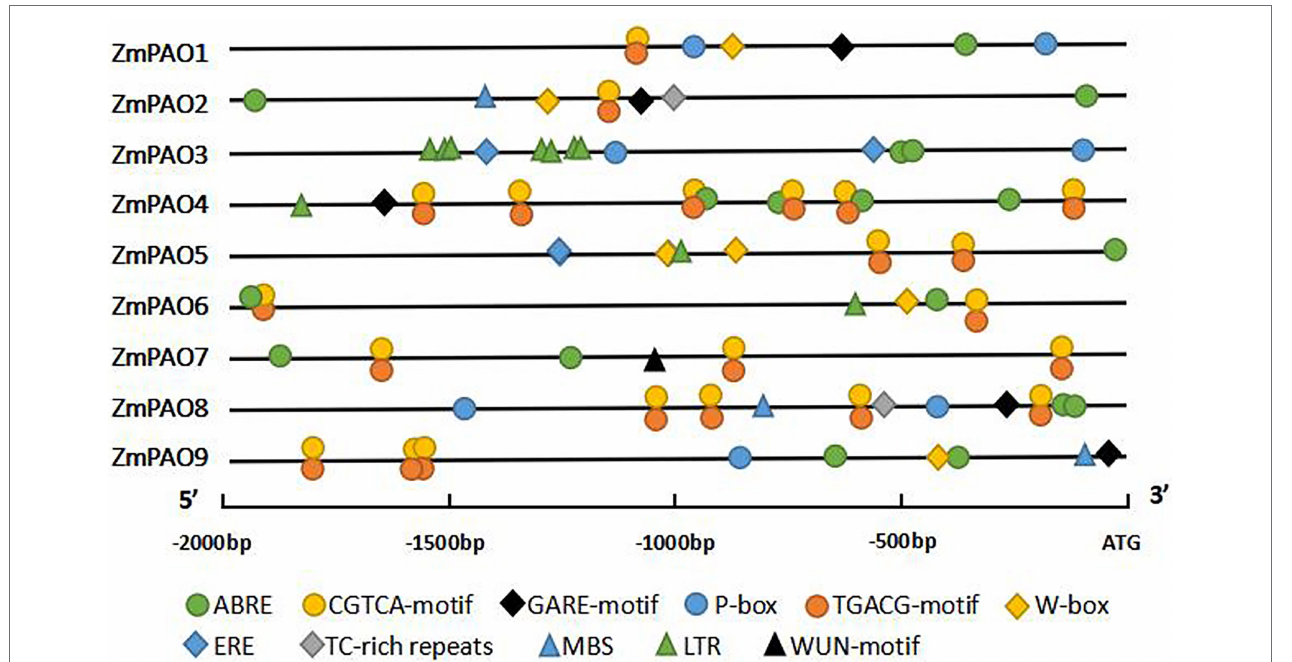
FIGURE 5 | Distribution of major stress-related cis-elements in the promoter sequences of the 9 ZmPAO genes. The putative core sequences of these cis-acting elements are represented by different symbols, as shown in the figure key at the bottom. The cis elements distributed on the sense chain and the reverse chain are above and below the black lines, respectively. The 2,000 bp sequences upstream of the initiation codon (ATG) of the PAO genes can be estimated using the scale per 500 bp at the bottom. ABRE, ABA responsive element; ERE, ethylene-responsive element; GARE-motif and P-box, gibberellin responsive element; CGTCA-motif and TGACG-motif, MeJA-responsive element; LTR, low temperature-responsive element; TC-rich repeats, defense and stress-responsive element; WUN-motif, wound-responsive element; MBS, MYB binding site. W-box, wound and pathogen responsive